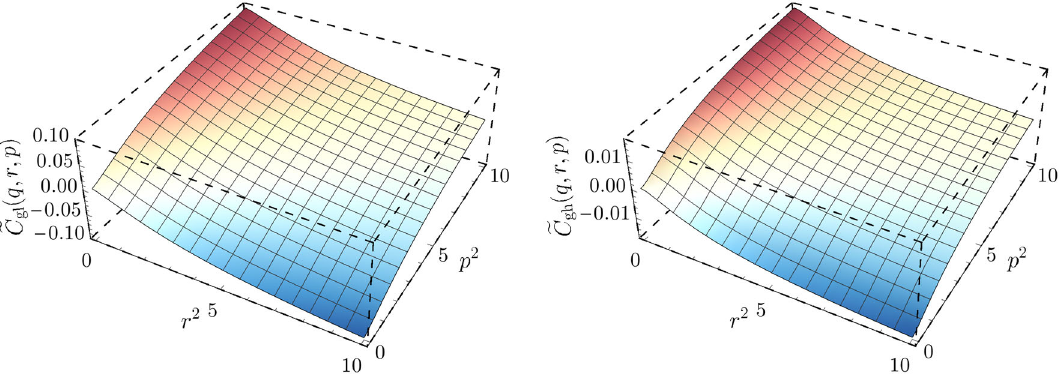
Fig. 9 Reconstructed form factors (cid:2) C gl and (cid:2) C gh of the pole parts of the three-gluon and gluon-ghost vertices. The momenta p and r are treated as